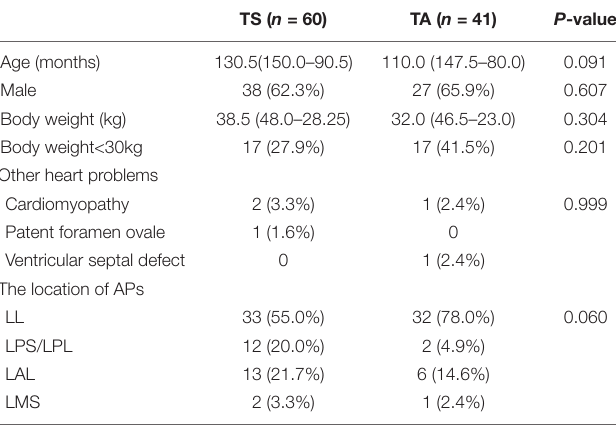
TABLE 1 | Baseline characteristics of patients in TS and TA groups.